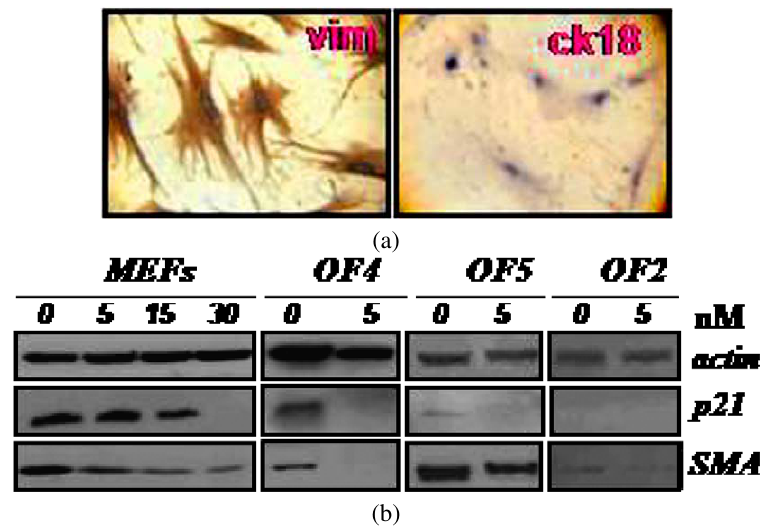
Fig. 2. Characterization and modulation of p21 expression in primary fibroblasts from oral cancers. (a) Immunostaining for vimentin (positive) and cytokeratin 18 (negative) was performed to confirm the fibroblastic identity of the cells. The cell fraction positive for vimentin exceeded 95% and was less than 5% for cytokeratin. All experiments were performed before cells reach passage number 10. (b) siRNA-mediated suppression of p21 results in the reduction of SMA protein levels in MEFs and primary fibroblasts from oral cancer (OF). Note that in OF2, baseline expression of p21 was minimal however a reduction in SMA was apparent following siRNA transfection for p21. No effect was found when cells were transfected with scrambled RNA (data not